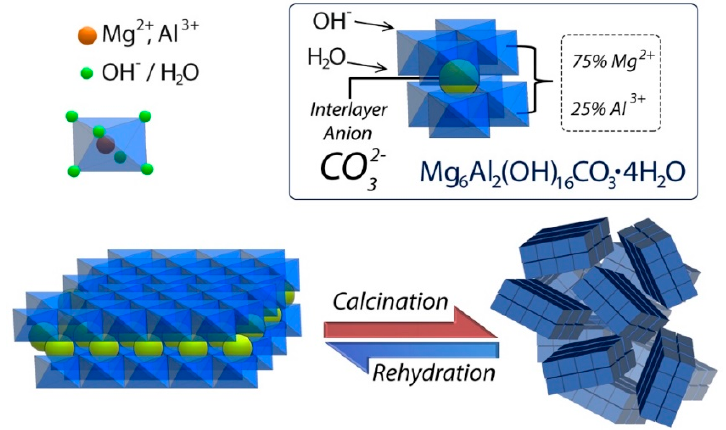
Figure 10. Illustration of the crystal structure, calcination of Mg–Al layered double hydroxide (LDH) and rehydration of the calcined